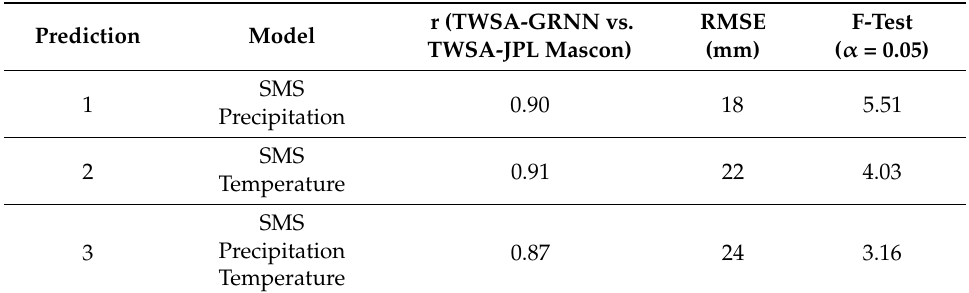
Table 4. Accuracy assessment of TWSA predicted by GRNN models for the testing period from February 2014 to March 2016 (n = 26). Prediction Model